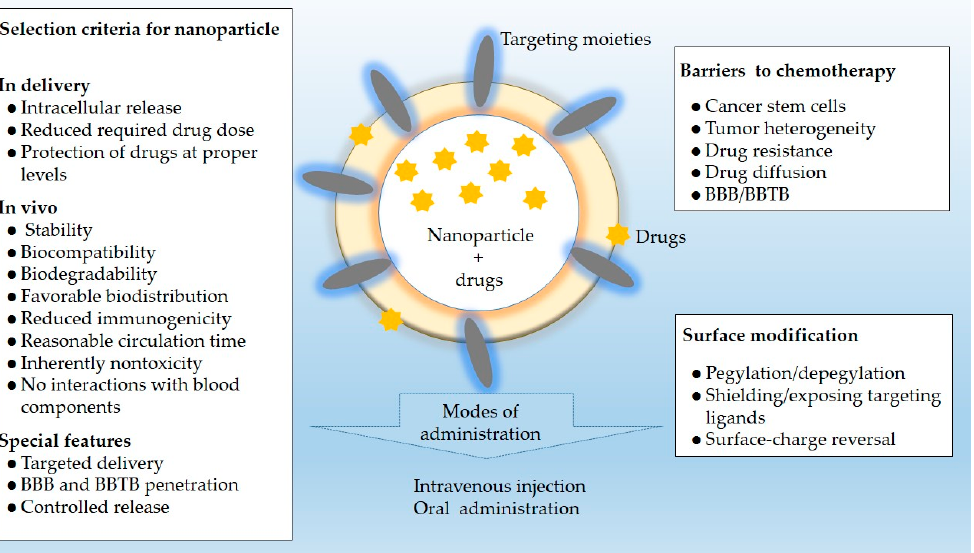
Figure 4. Selection criteria, barriers to chemotherapy, and surface modification associated with NPs for drug delivery in selected solid tumors mentioned in this review.